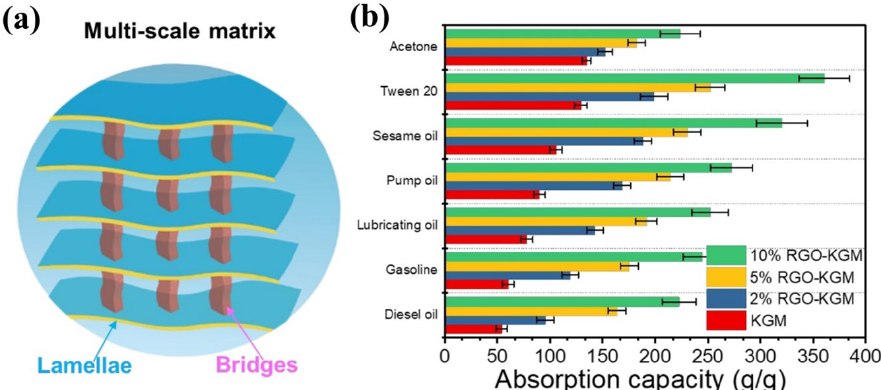
Figure 12. ( a ) The schematic of the as-prepared RGO-KGM carbon aerogel with mineral bridge structure. ( b ) Absorbency of the KGM and (2%, 5%, 10%) RGO-KGM carbon aerogels for various oils and organic liquids in the oil system. Reproduced with permission [159]. Copyright 2020,